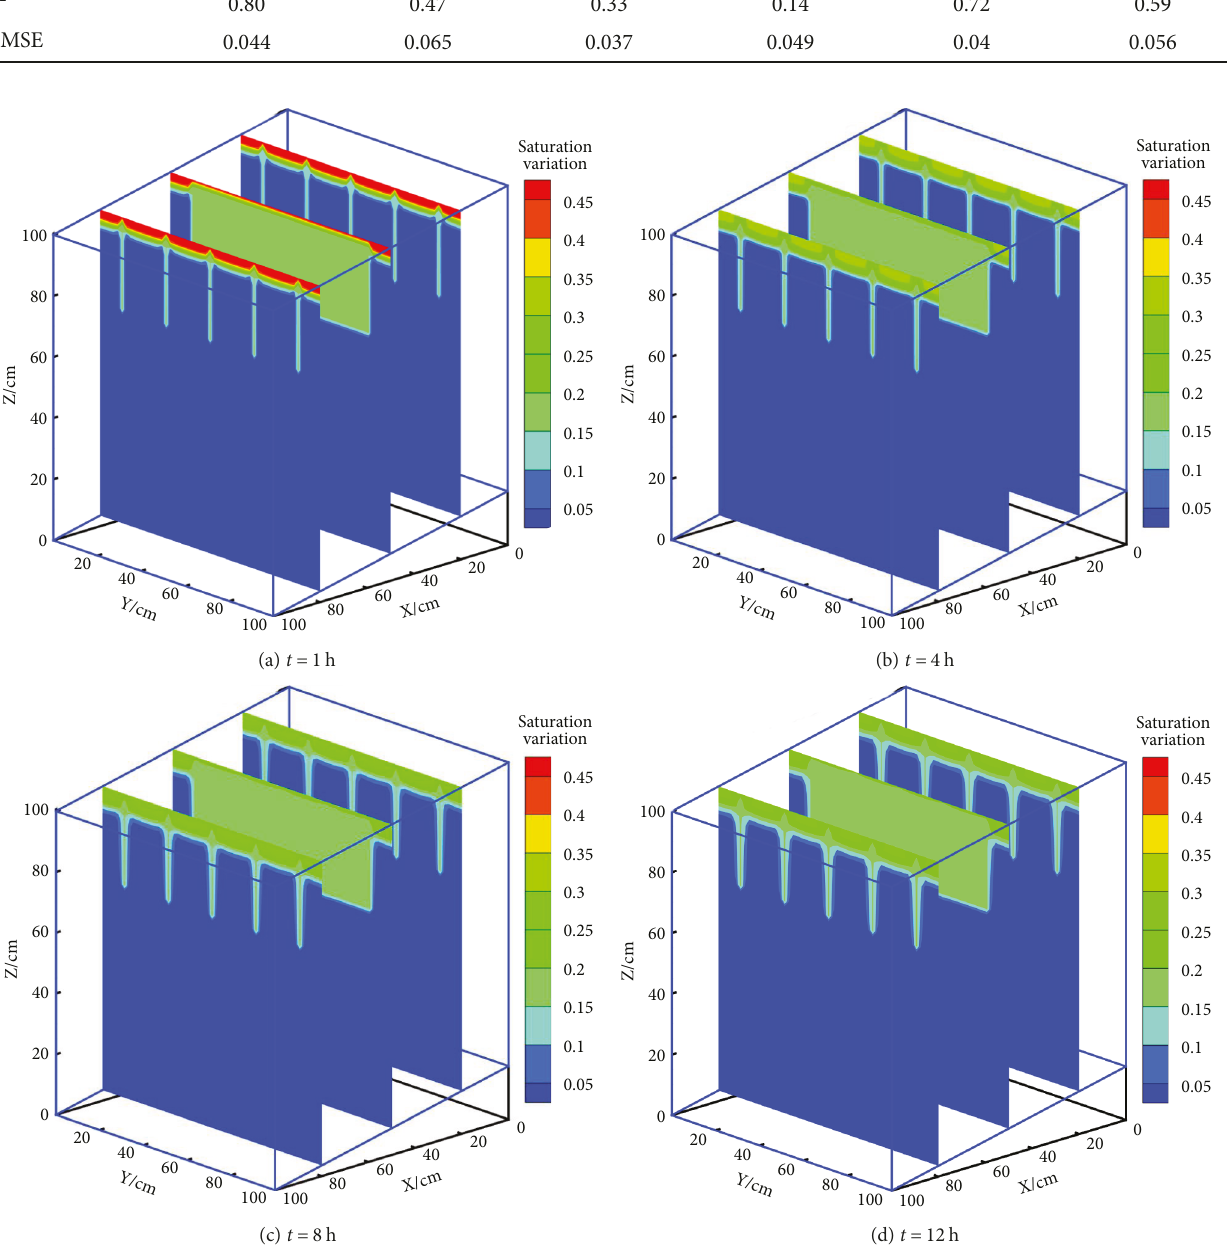
Figure 10: SMC simulation of soil water movement of the experiment